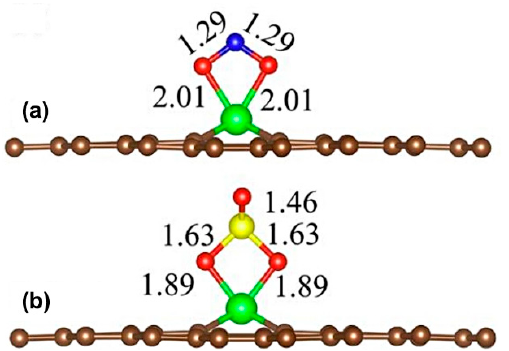
Figure 6. Most stable structures of NO 2 ( a ) and SO 3 ( b ) adsorption on Fe-doped vacancy-defected graphene (The bond length in Å). Brown, green, red, blue, and yellow spheres represent C, Fe, O, N, and S atoms, respectively. Figure modified from [80].